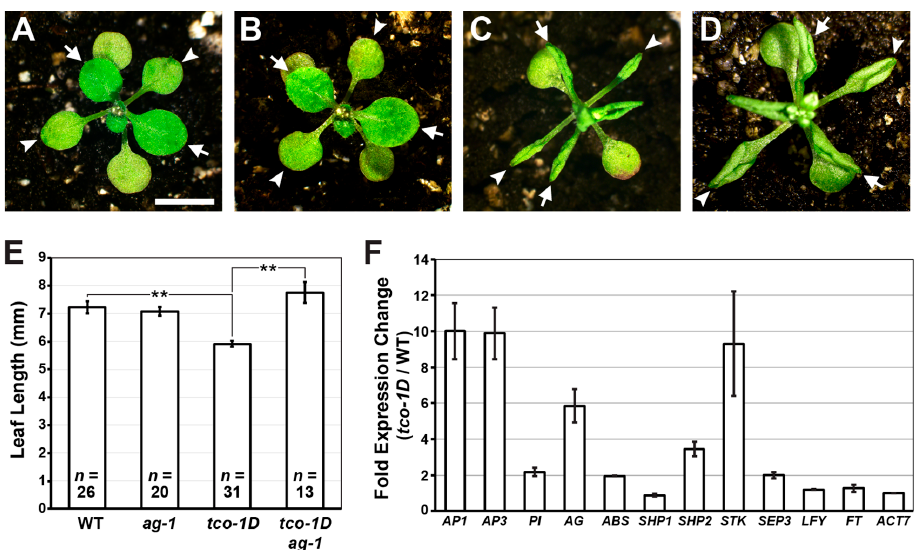
Figure 3. Developmental defects of tco-1D are associated with misregulation of multiple floral organ identity genes in Arabidopsis . ( A – D ) 20 days after germination (DAG) plants of wild type ( A ), ag-1 ( B ), tco-1D ( C ) and tco-1D ag-1 ( D ). Arrowheads denote first pair of vegetative leaves, while arrows indicate third and fourth leaves. Bars: 5 mm. ( E ) Length of third/fourth vegetative leaves of wild type (WT), ag-1 , tco-1D and tco-1D ag-1 plants. Data are represented as mean +/ − SE. Asterisks denote statistically significant differences (** p < 0.001; two-tailed t-test). Sample size ( n ) of each genotype is given. ( F ) Quantitative RT-PCR on genes controlling floral organ identity, floral meristem identity and flowering time in tco-1D seedlings (7 DAG) relative to wild type (WT). Assessed genes are APETALA1 ( AP1 ), APETALA3 ( AP3 ), PISTILLATA ( PI ), AGAMOUS ( AG ), ARABIDOPSIS B SISTER ( ABS ), SHATTERPROOF1 ( SHP1 ), SHATTERPROOF2 ( SHP2 ), SEEDSTICK ( STK ), SEPALLATA3 ( SEP3 ), LEAFY ( LFY ), and FLOWERING LOCUS T ( FT ). Fold expression change ( tco-1D /WT) was normalized against ACTIN7 ( ACT7 ) expression. Data are represented as mean +/ − SE of two biological replicates. Primer sequences are provided in Table S1.